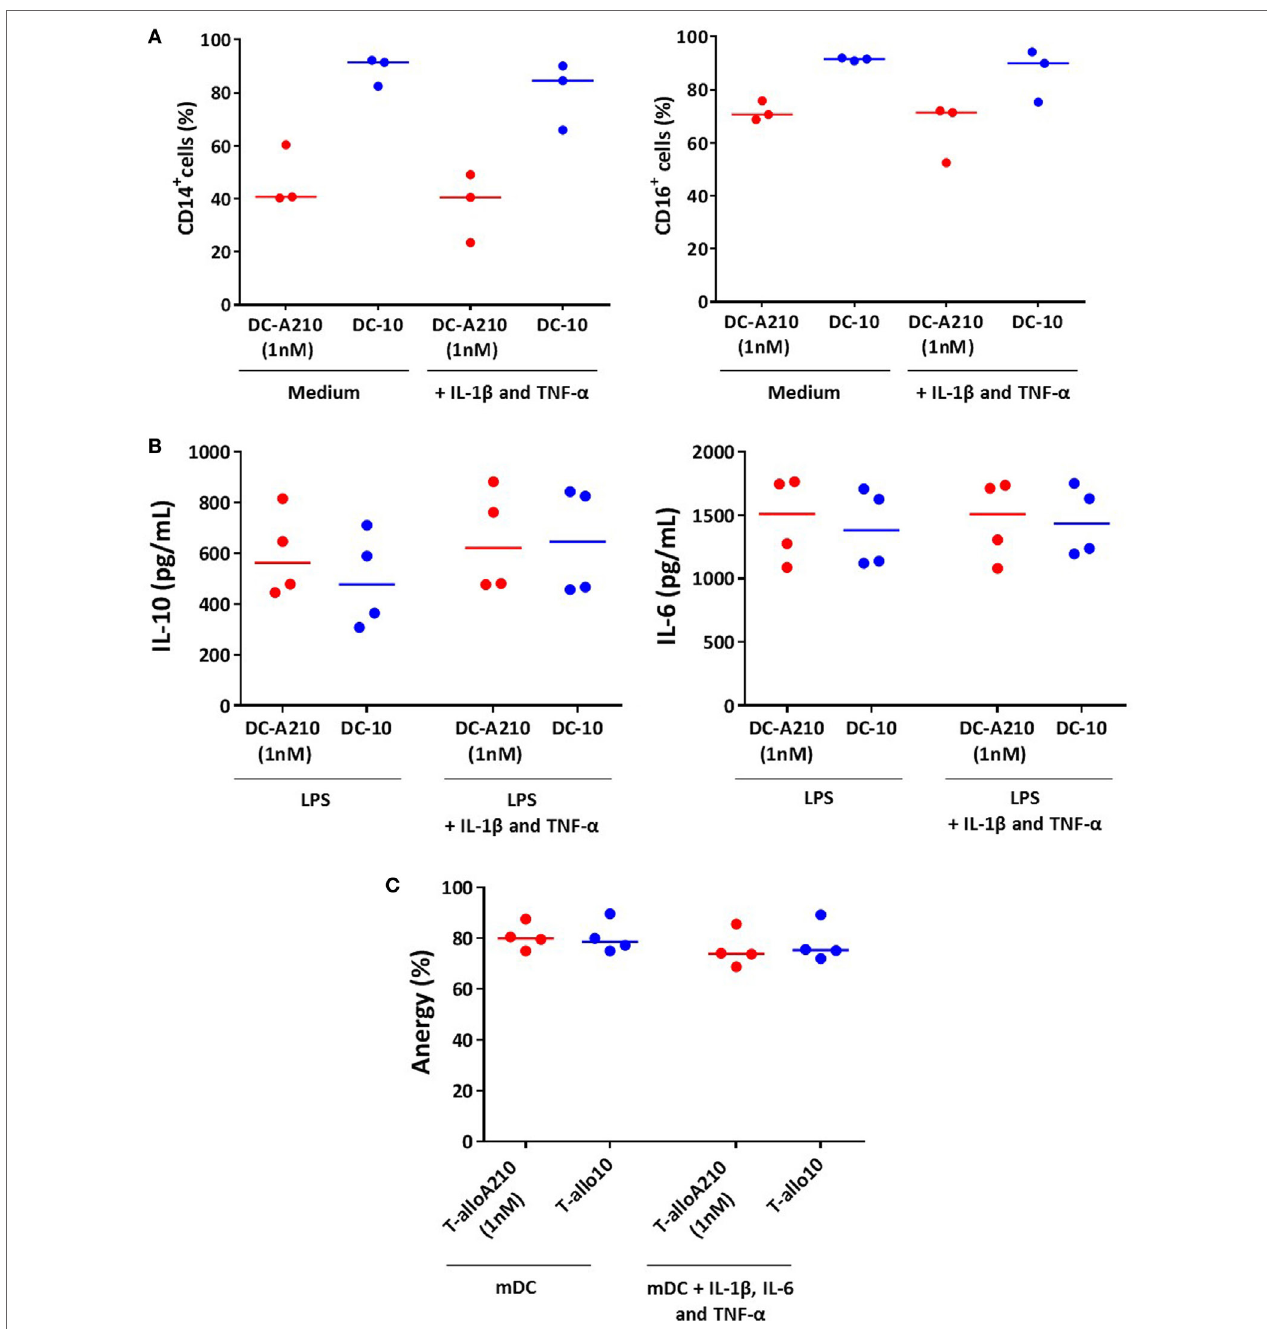
FigUre 5 | DC-A210 and T-alloA210 cells are stable upon exposure to inflammatory cytokines in vitro . (a) DC differentiated in the presence of APVO210 (DC-A210) and tolerogenic DC (DC-10) were incubated for 24 h with IL-1 β and TNF- α , and percentage of CD14 + , and CD16 + cells was evaluated by flow cytometry ( n = 3). (B) DC-A210 and DC-10 were stimulated with LPS for 48 h in the presence or absence of IL-1 β and TNF- α , and production of IL-10 and IL-6 was evaluated by ELISA in culture supernatants ( n = 4). (c) T cells were cultured with allogenic DC-A210 + APVO210 (T-alloA210: 1 nM), DC-10 + IL-10 (T-allo10) or mature DC (mDC) (T-allo). T-alloA210, T-allo10, and T-allo were stained with CFSE, stimulated for 3 days with allogeneic mDC in the presence or absence of IL-1 β , IL-6, and TNF- α , and proliferation was evaluated by means of CFSE dye dilution using flow cytometry ( n = 4). Percentage of anergy calculated using the formula (% proliferation (T-allo + mDC) − % proliferation (T-alloA210 or T-allo10 + mDC)/% proliferation of T-allo + mDC) is shown. Median values are indicated, each dot represents a donor, and lines indicate median values. Paired t -tests with Bonferroni correction were performed for statistical